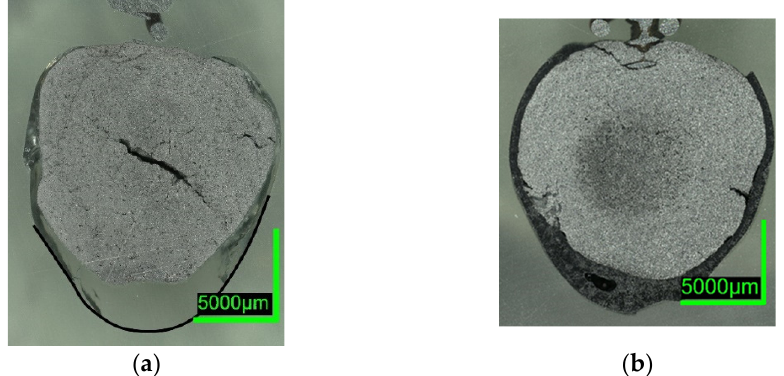
Figure 7. Digital microscope images of ( a ) 0%C-ULC-1; ( b ) 0%C-ULC-10s-3, dipped into liquid ULC steel.